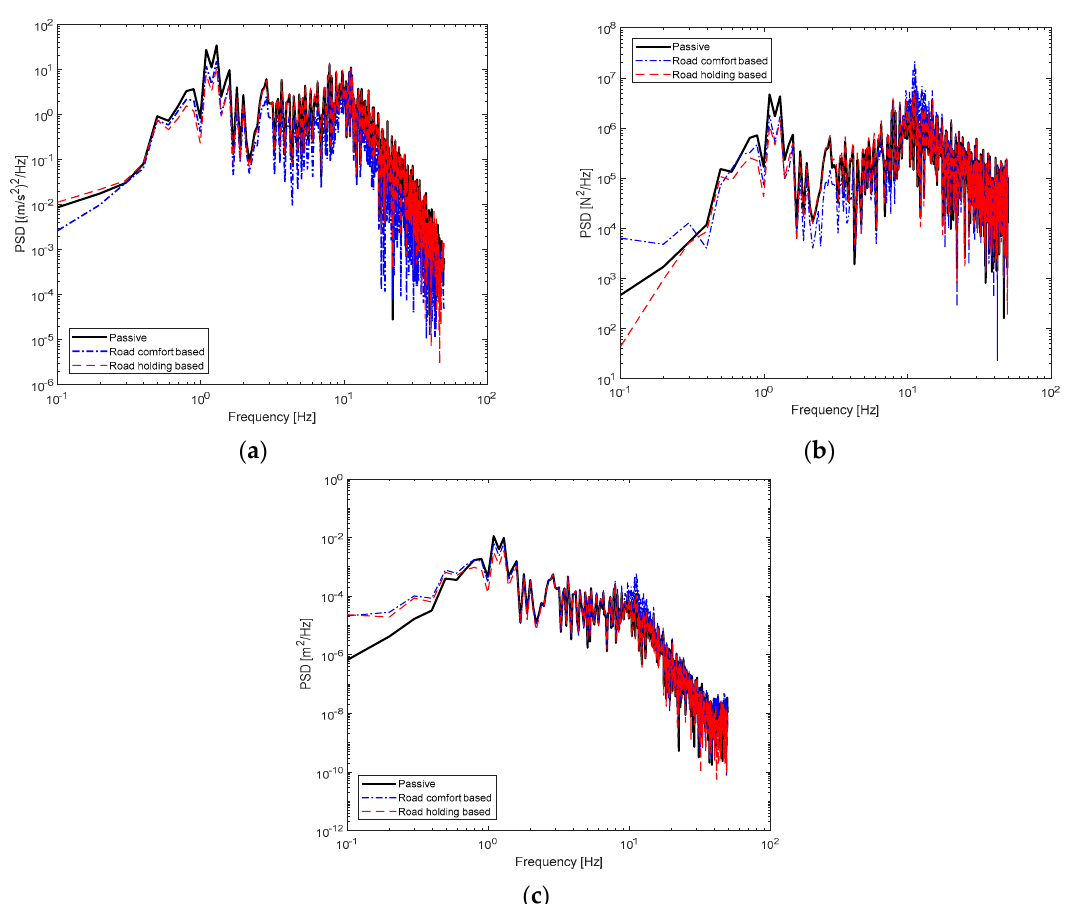
Figure 6. The power spectrum density (PSD) of different suspension dynamic performance criteria. ( a ) Vertical acceleration of the vehicle body; ( b ) tyre dynamic load at the front left wheel; ( c ) suspension deflection at the front left wheel.